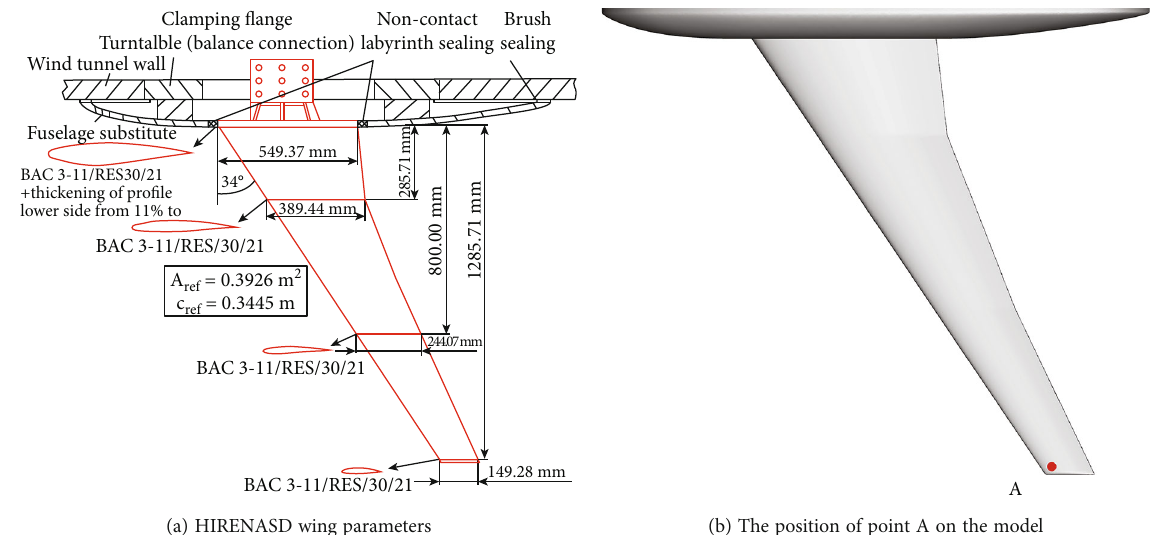
Figure 3: HIRENASD wing model and parameters.